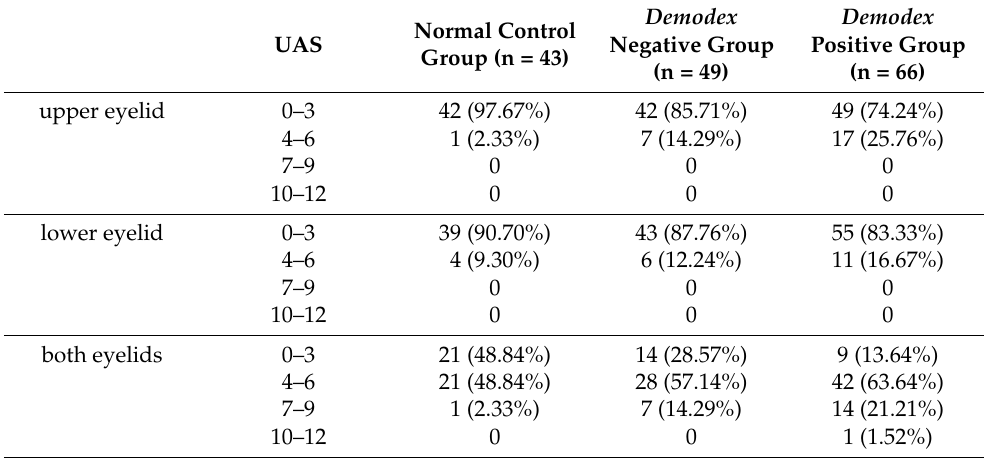
Table 3. The number (ratio) of uneven atrophy score in three